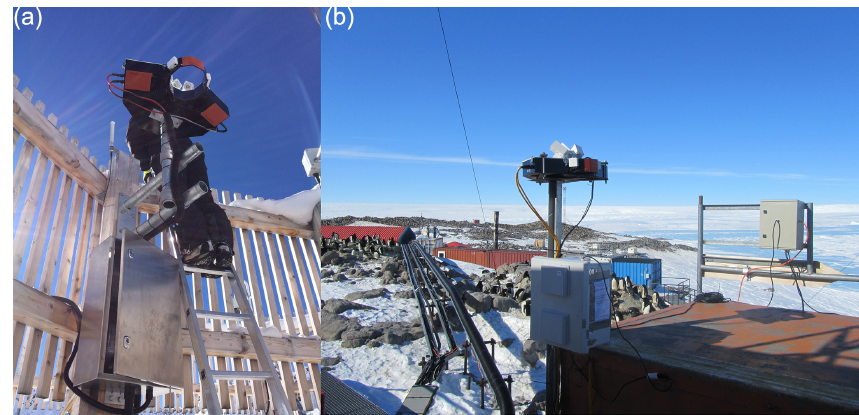
Figure 2. Experimental setup conditions of the MASC in a DFIR near Davos (a) and on top of a container at Dumont d’Urville (b) .